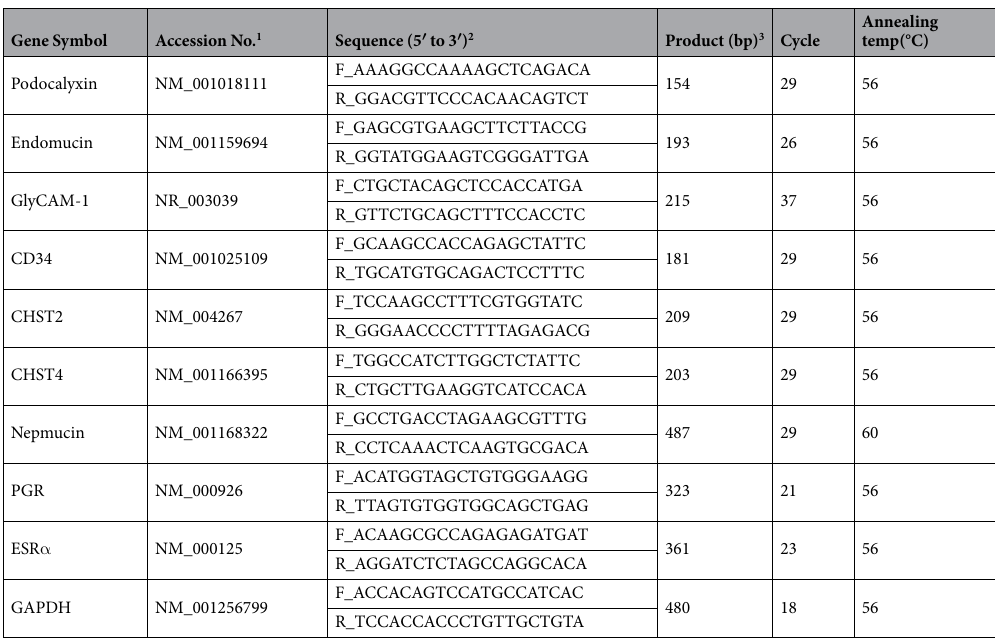
Table 2. Sequences of primers used for RT-PCR in this study. 1 Accession No. refers to the registered No of each respected mRNA. 2 F: Forward primer; R: Reverse primer. 3 Amplicon size in base